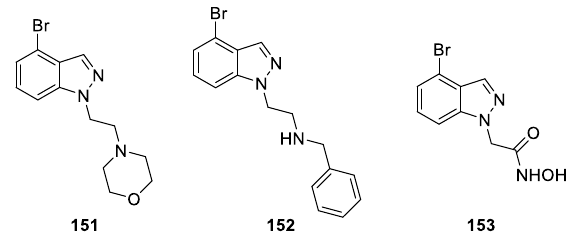
Figure 42. Chemical structures of 4-bromo-1 H -indazole derivatives 151 , 152 and 153 .